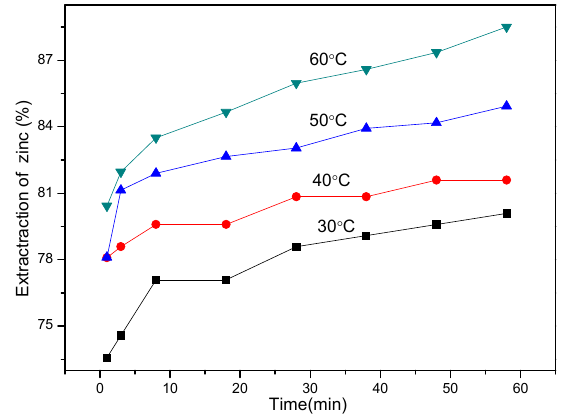
Figure 4. Effect of temperature (mass of solid 20 g, volume of solution 1000 mL, concentration of ammonia and ammonium chloride 2.5 mol/L and 5 mol/L, respectively).